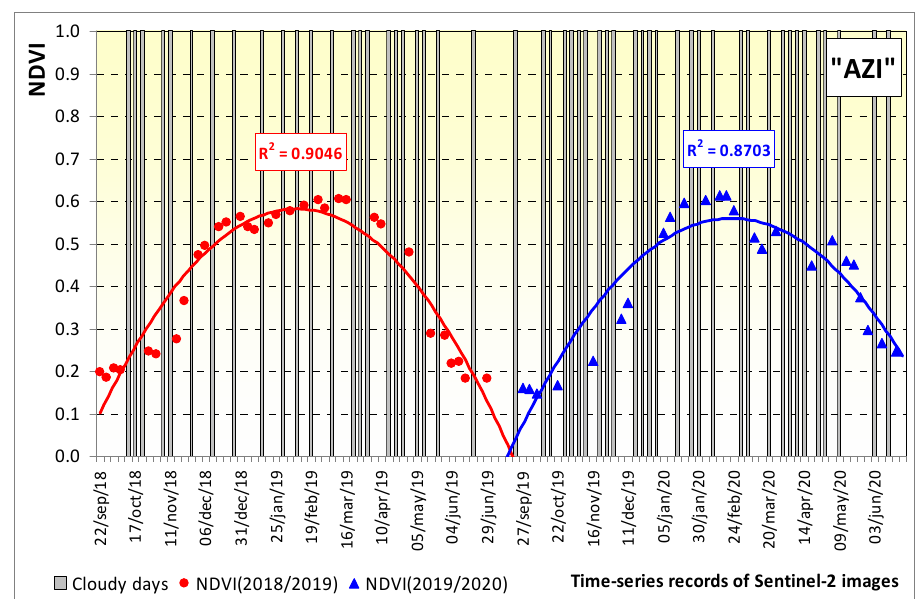
Figure 9. NDVI time-series records obtained in 2018/2019 and 2019/2020 in “AZI” field.